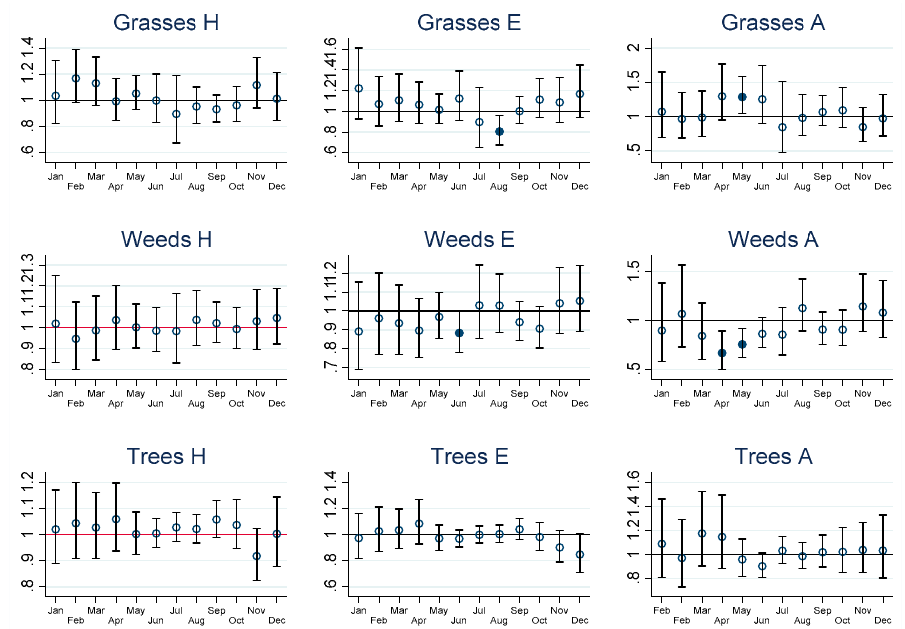
Figure 5. Short-term incidence rate ratios (IRRs) in adults for COPD health outcomes. H = hospitalisation, E = emergency presentations, A = ambulance callouts. IRRs significantly different from 1 are high- lighted using solid dots. IRRs refer to hospital admissions (H), emergency department presentations (E) and ambulance callouts (A) and pollen (Grasses, Weeds, Trees) by month. The estimated IRRs and associated 95% confidence intervals (95% CI) are based on an increase in 10 grains per cubic metre (10 grains per m 3 ) compared to zero grains per m 3 . Furthermore, the IRRs are based on the sum of the coefficients of the 0–7 day lags between the exposure on day zero and the daily health outcomes from day zero to day